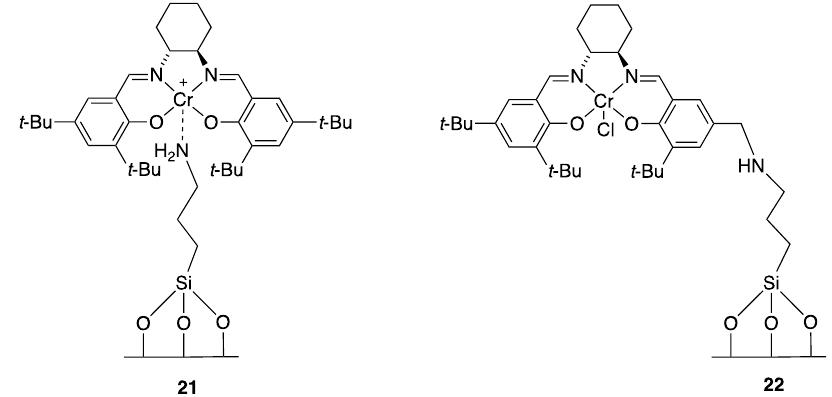
Figure 6. Cr–salen complexes anchored to functionalized silicates SiO 2 , ITQ-2 and MCM-41.